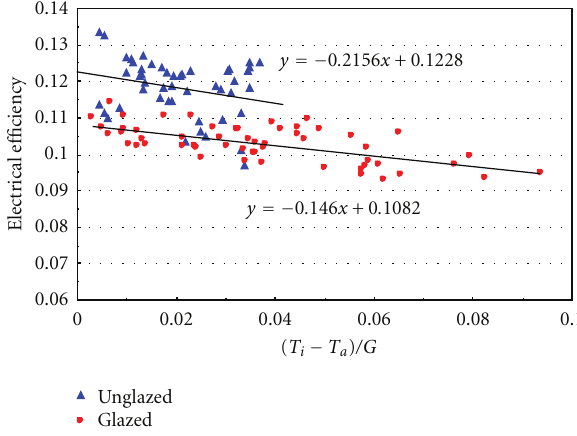
Figure 6: Glazed and unglazed PVT collectors thermal e ffi ciency. Figure 7: Glazed and unglazed PVT collectors electrical e ffi ciency.